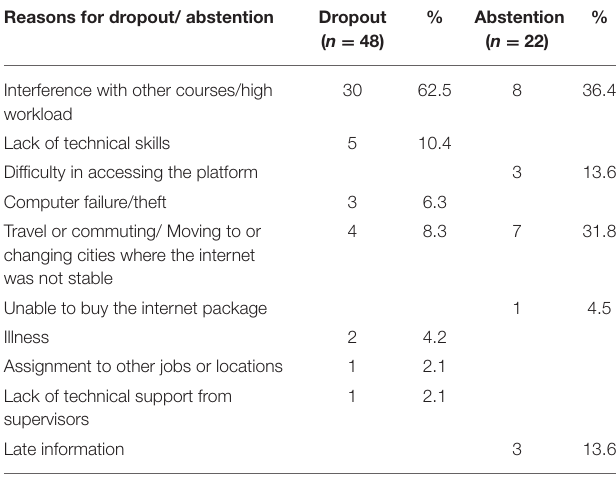
TABLE 4 | Reasons for course dropout and